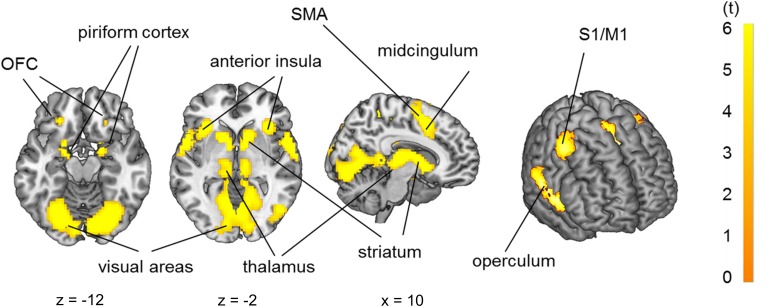
Brain activation due to olfactory stimulation: piriform cortex, orbitofrontal cortex, primary sensorimotor cortices (S1/M1), operculum, insula, striatum, thalamus and visual cortex. p < 0.05 FWE-corrected on the brain slices, p < 0.001 FWE-corrected on the inflated brain on the right side.